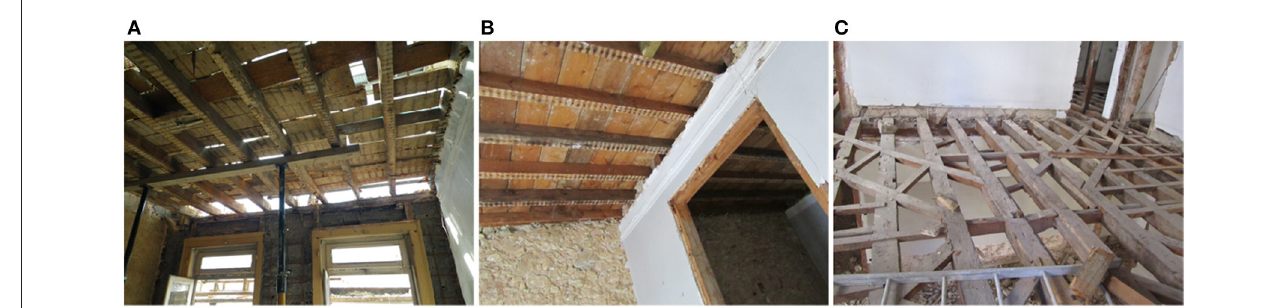
FIGURE 6 | Masonry walls with different type of materials: (A) Rubble stone, (B) Brick, and (C) Concrete block.